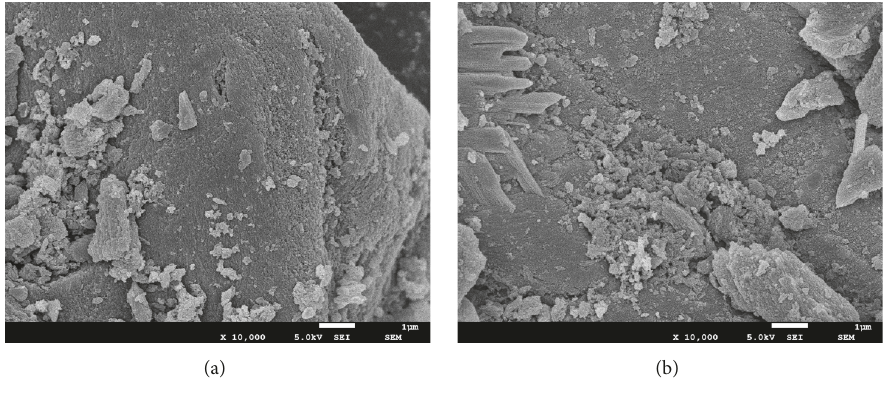
Figure 1: SEM images of (a) Pd/C and (b) Pd/C-OH − .